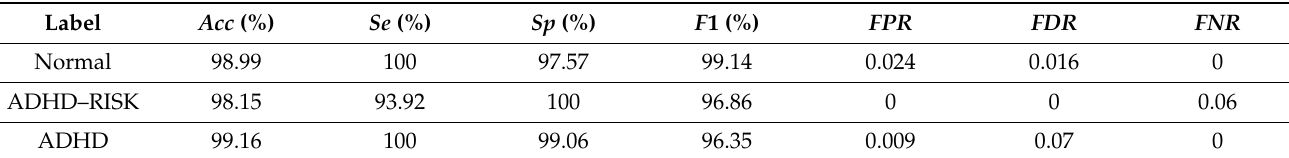
Table 3. ADHD screening results through a deep learning model applied with bidirectional LSTM and channel attention.